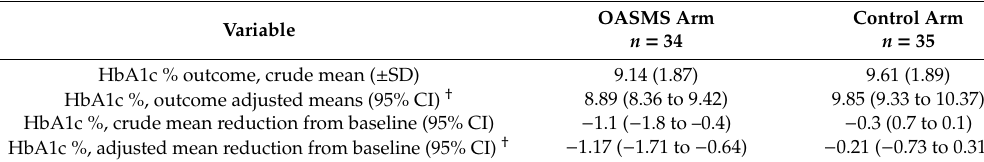
Table 3. Crude and adjusted HbA1c outcomes.